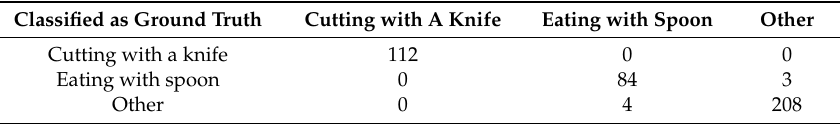
Table 7. Classification results for two layers of